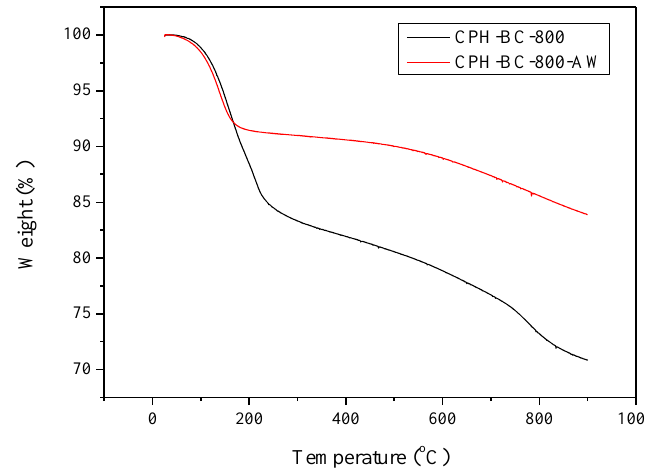
Figure 5. Thermogravimetric analysis (TGA) diagrams of CPH-BC-800 and CPH-BC-800-AW.